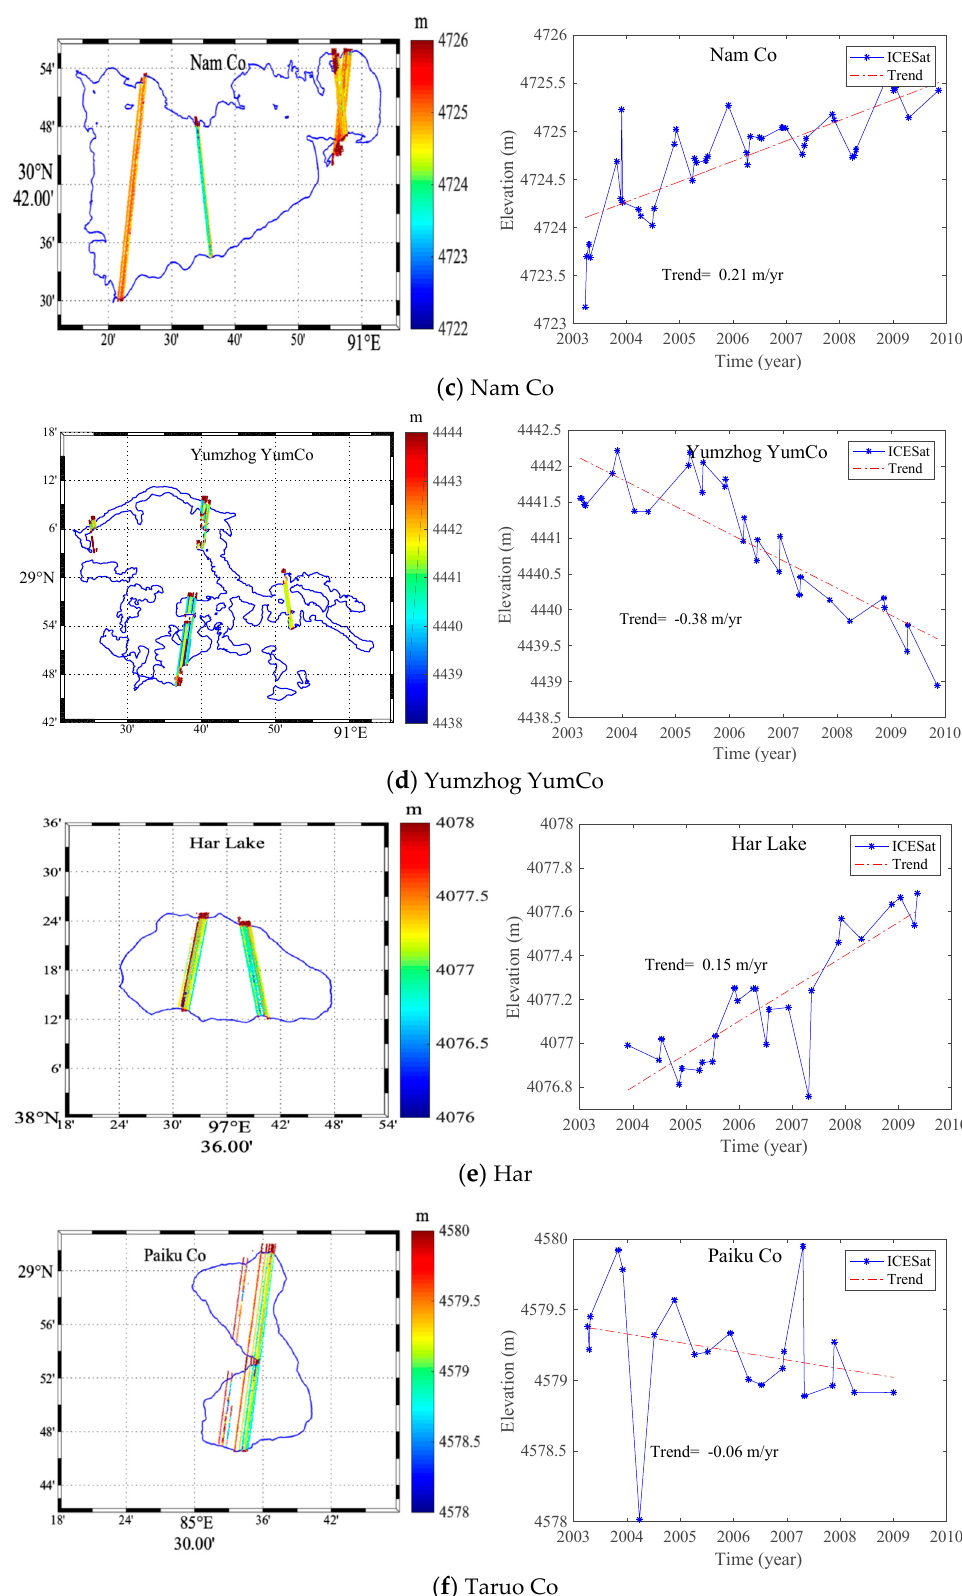
Figure 13. The ICESat tracks through lakes (left panels) and the water level changes (right panels) of ( a ) Qinghai, ( b ) Seling Co (also called Selin Co in some studies), ( c ) Nam Co, ( d ) Yumzhog YumCo, ( e ) Har (also called Hala Hu), and ( f ) Taruo Co over the period from March 2003 to October 2009. We note that “Co” means lake in Tibetan language.